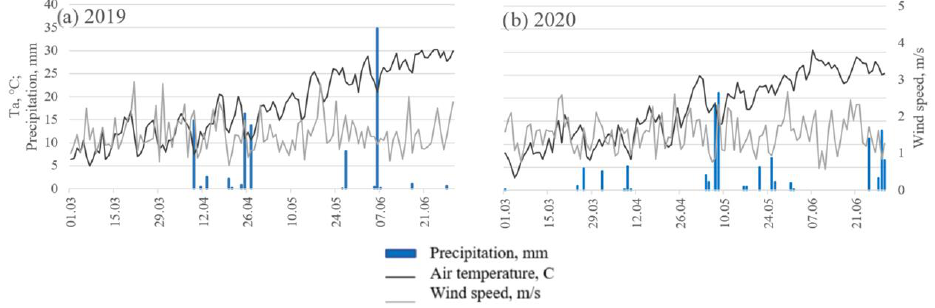
Figure 3. Maximum daily temperature, precipitation, and average wind speed for the spring season (March–June) of ( a ) 2019 and ( b ) 2020.